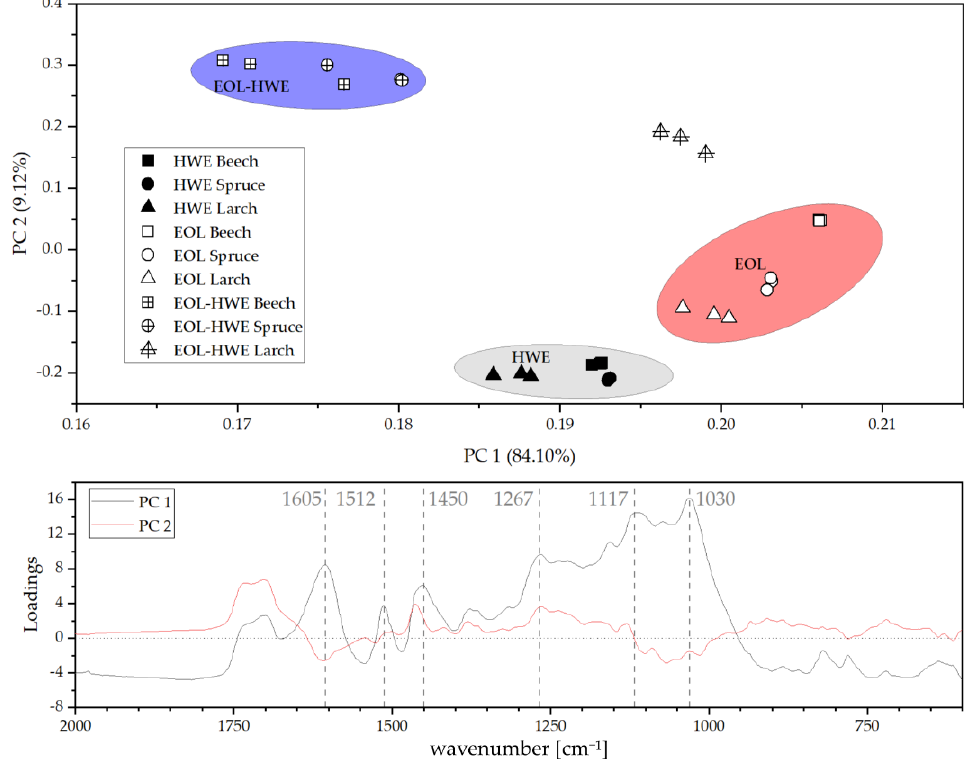
Figure 6. PC 1 vs. PC 2 plot (upper panel) and loadings of PC 1 and PC 2.